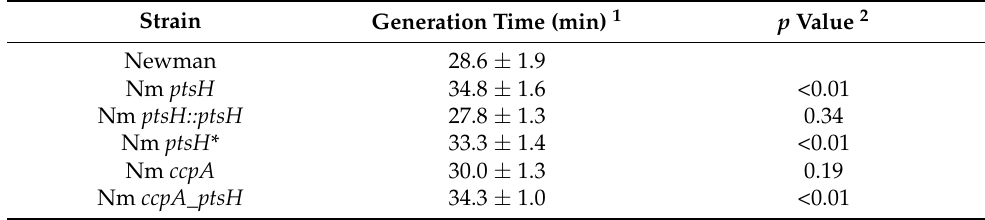
Table 2. Generation time of S. aureus strains cultivated in TSB under aerobic